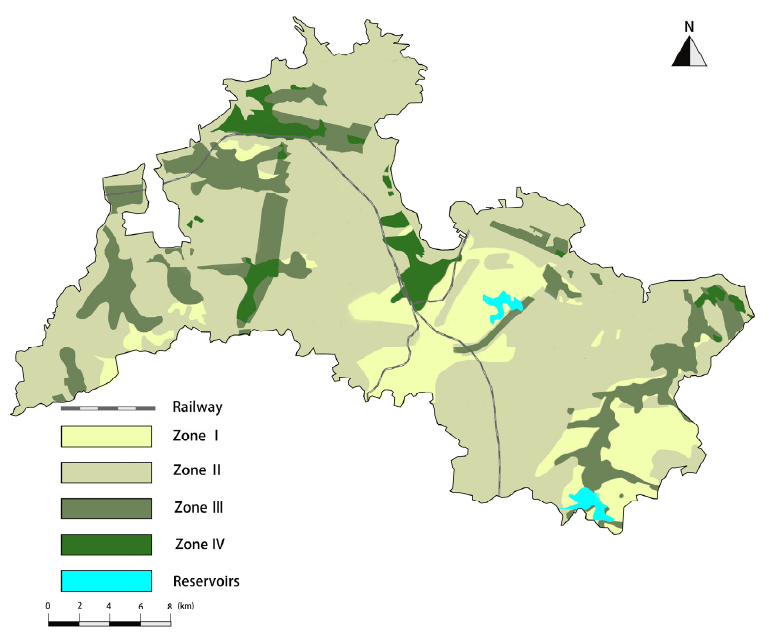
Figure 4. Comprehensive evaluation diagram of underground space resource development suitability (0~30 m).